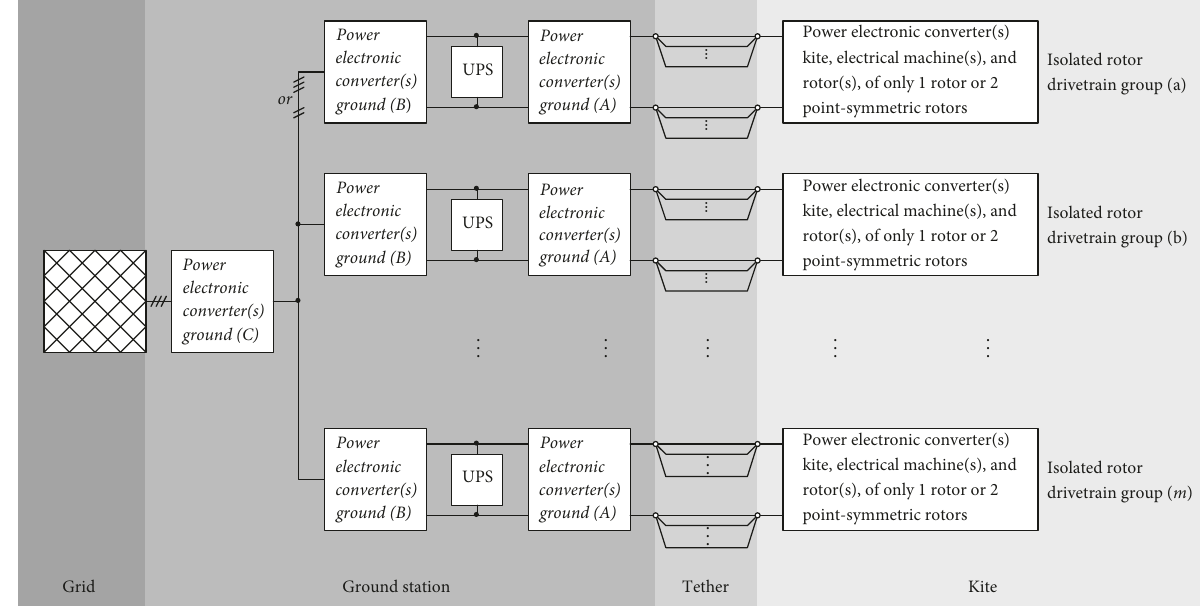
Figure 12: Block diagram of the generalization of the proposed solution to “isolated drivetrain groups.” The “power electronic convert(s) ground”-blocks in italics depend on design